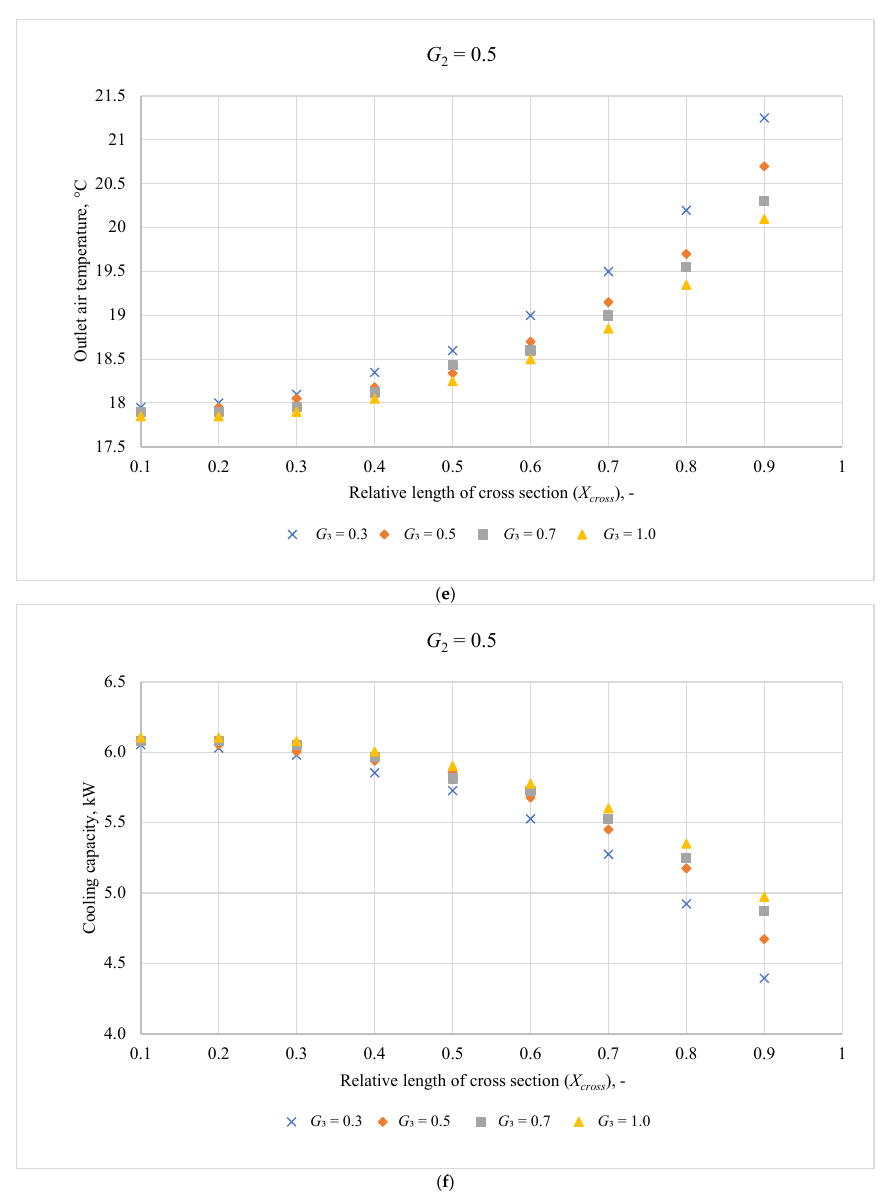
Figure 3. Cooling performance of multi-stage DPIEC in the case of ambient air parameters: t = 30 ◦ C, RH = 45%. ( a ) Outlet air temperature for W 2 / W 1 equal to 0.1. ( b ) Cooling capacity for W 2 / W 1